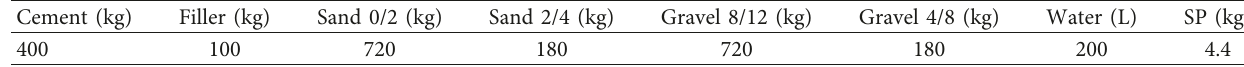
Table 6: Composition of 1m 3 of SCCM and